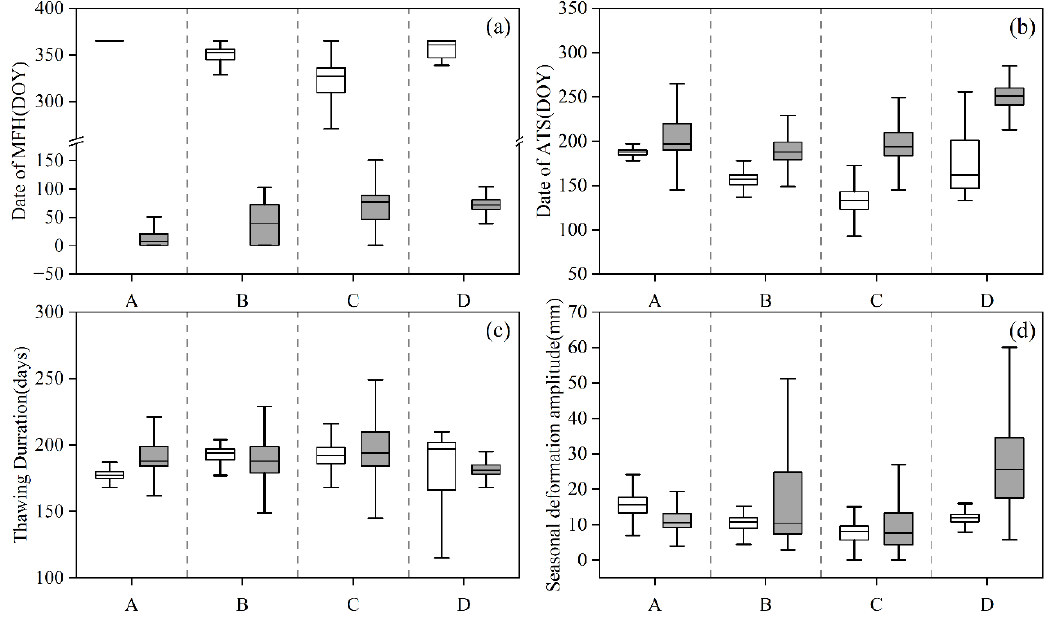
Figure 12. Date of MFH ( a ), date of ATS ( b ), thawing duration ( c ), and seasonal deformation ampli- tude ( d ) of the regions (black boxes) and their surrounding regions (gray boxes) which delineated with red lines in Figure 11.